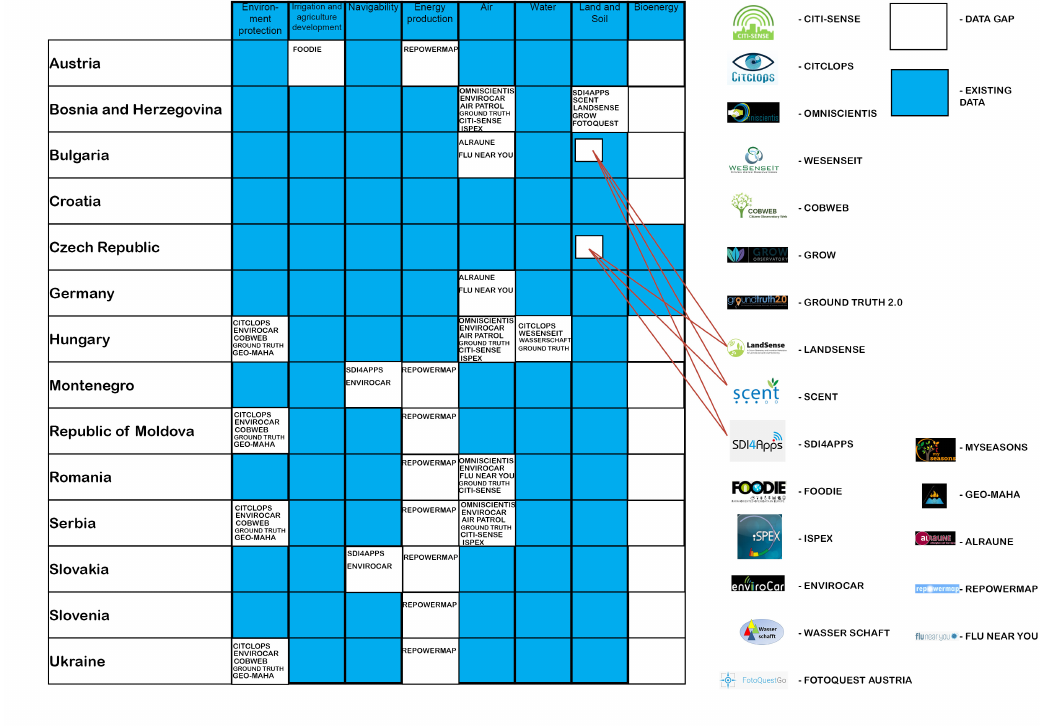
Figure 7. Thematic and geographic coverage of Citizen Science projects in the Danube